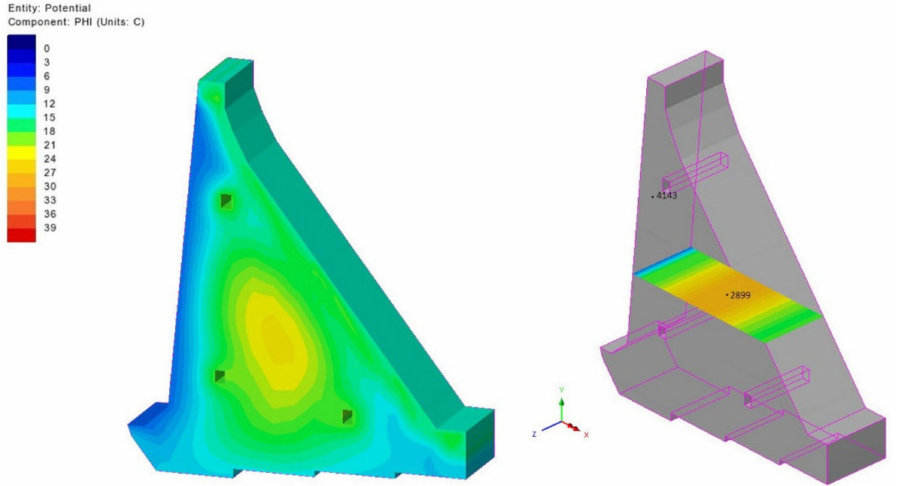
Figure 18. Temperature field for day 1804 (25th of September of the sixth year) with horizontal cross-section at 170.50 masl; maximum: node 2899, minimum: node